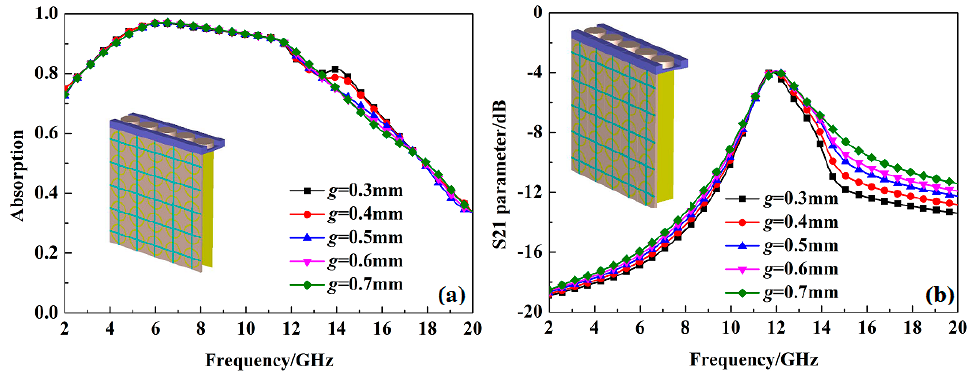
Figure 11. The absorption and transmission coefficient at different size parameter g , ( a ) the absorption, ( b ) the transmission coefficient.